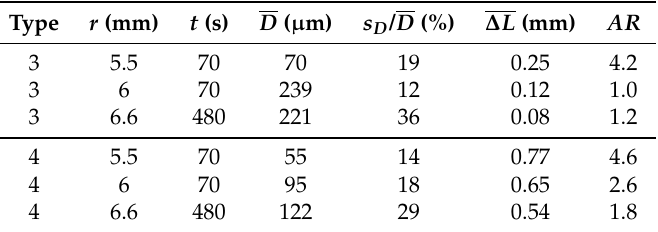
Table 4. Mean geometrical parameters for sets of nozzles fabricated from different capillary types and with different heating conditions at ( z = 15